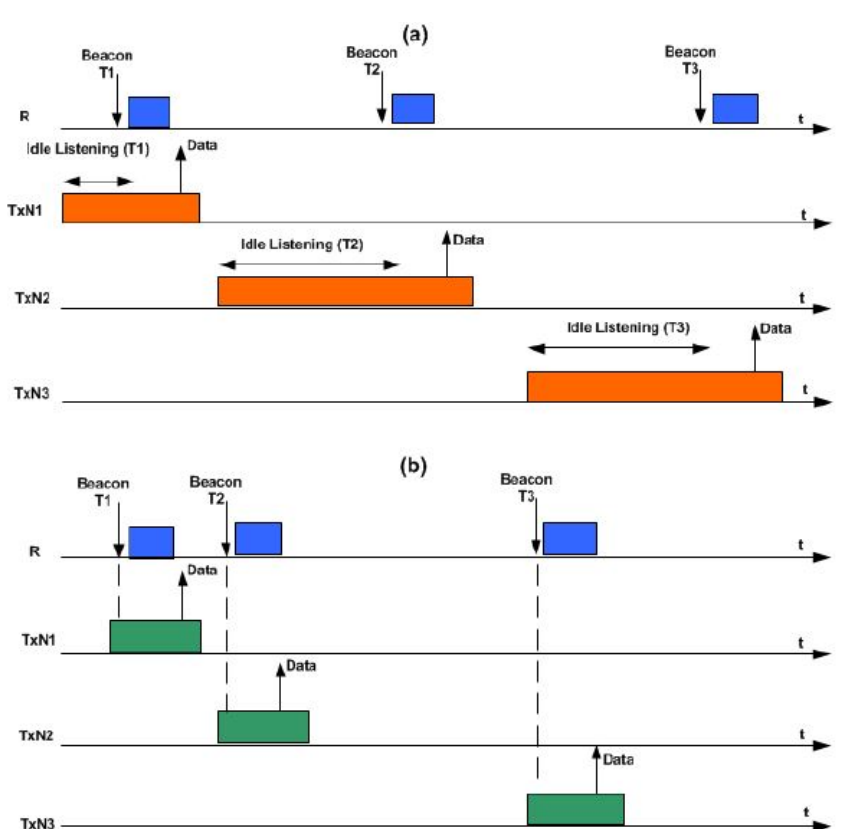
Figure 1. Receiver-initiated Preamble Sampling Medium Access Control (PS-MAC) Figure 1. Receiver ‐ initiated Preamble Sampling Medium Access Control (PS ‐ MAC) general